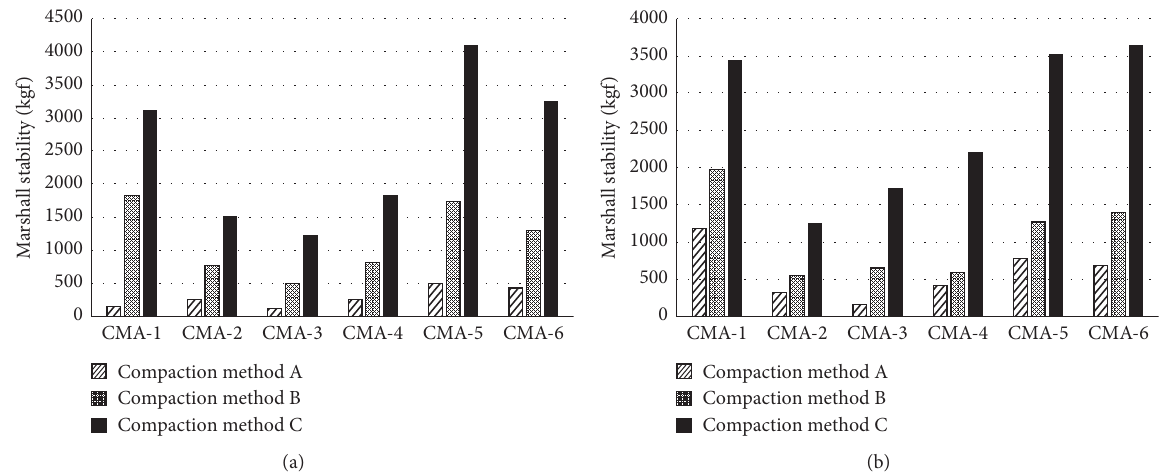
Figure 5: Marshall stability of the sample with moisture damage for (a) short- and (b) long-term